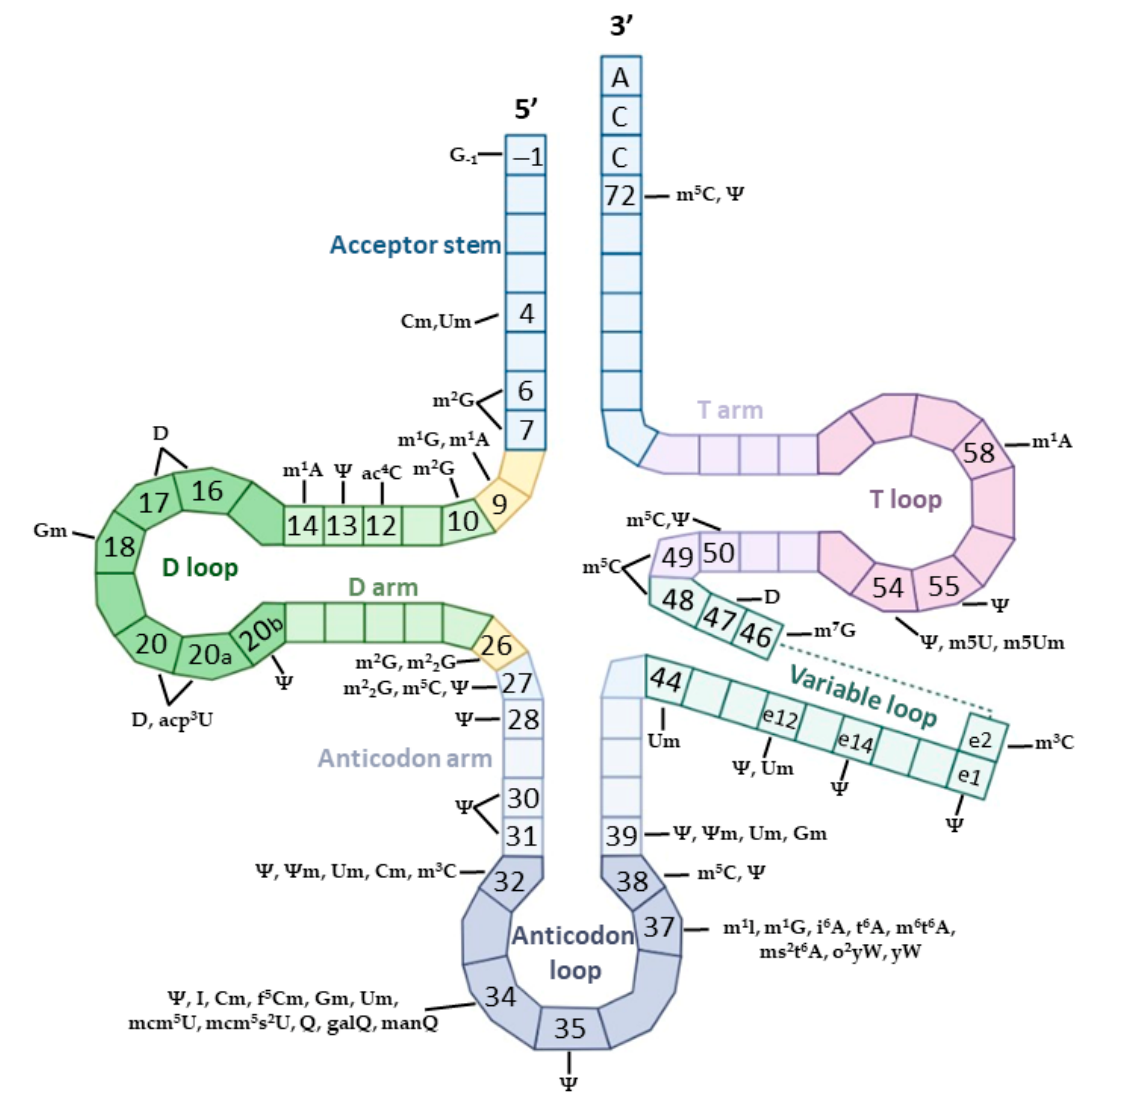
Figure 3. Graphical representation of the identified nucleotide modifications in eukaryotic tRNAs and their corresponding position in the tRNA sequence.